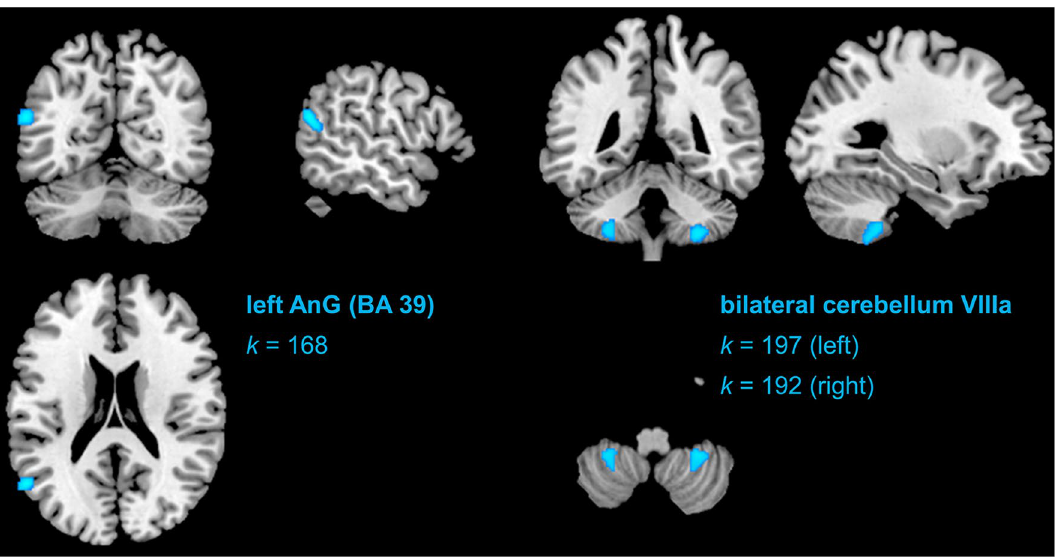
Figure 1. Graphical depiction of identified significant clusters in the VBM analysis searching for decreases in rGMV in the infrasound verum condition (relative to the sham [placebo] condition) from